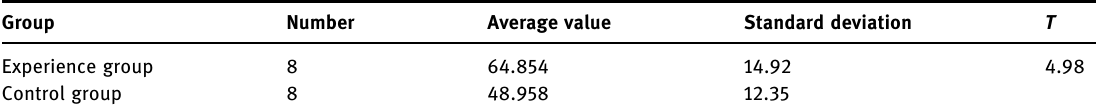
Table 3: T value test